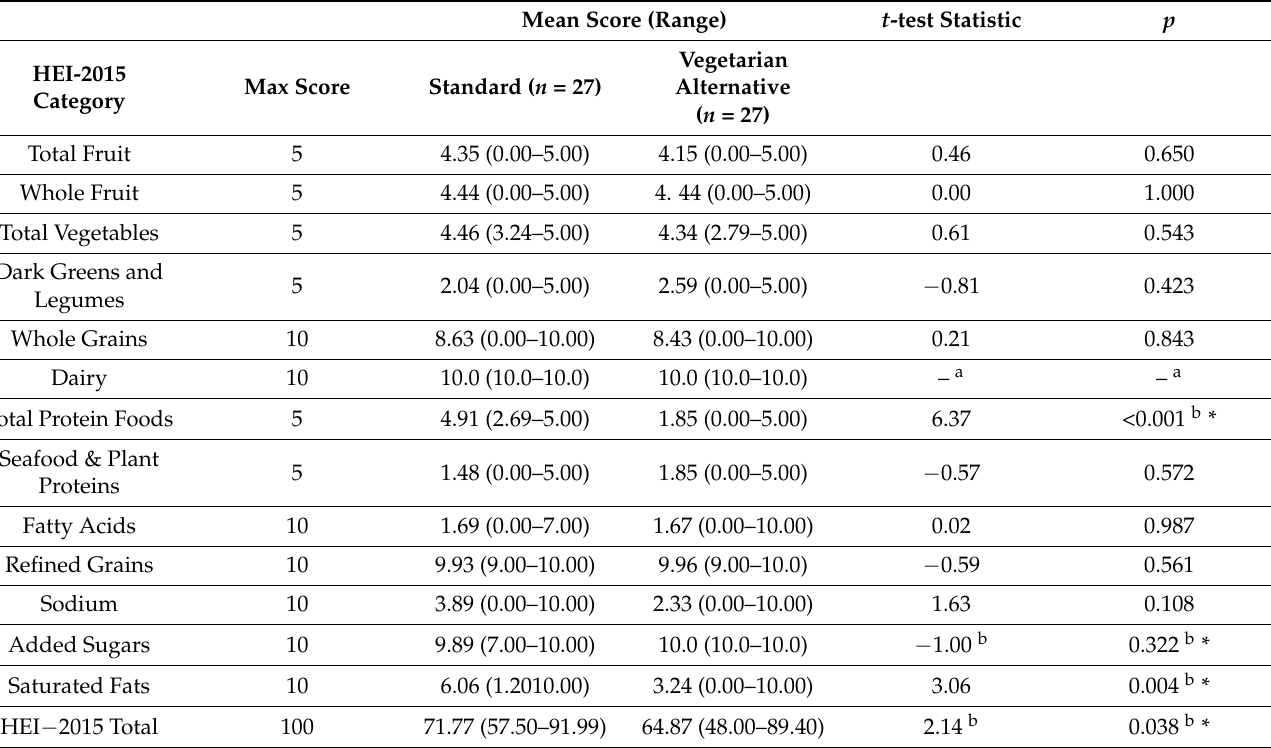
Table 5. A t -test comparison of the standard and vegetarian alternative HEI-2015 scores. Mean Score (Range)